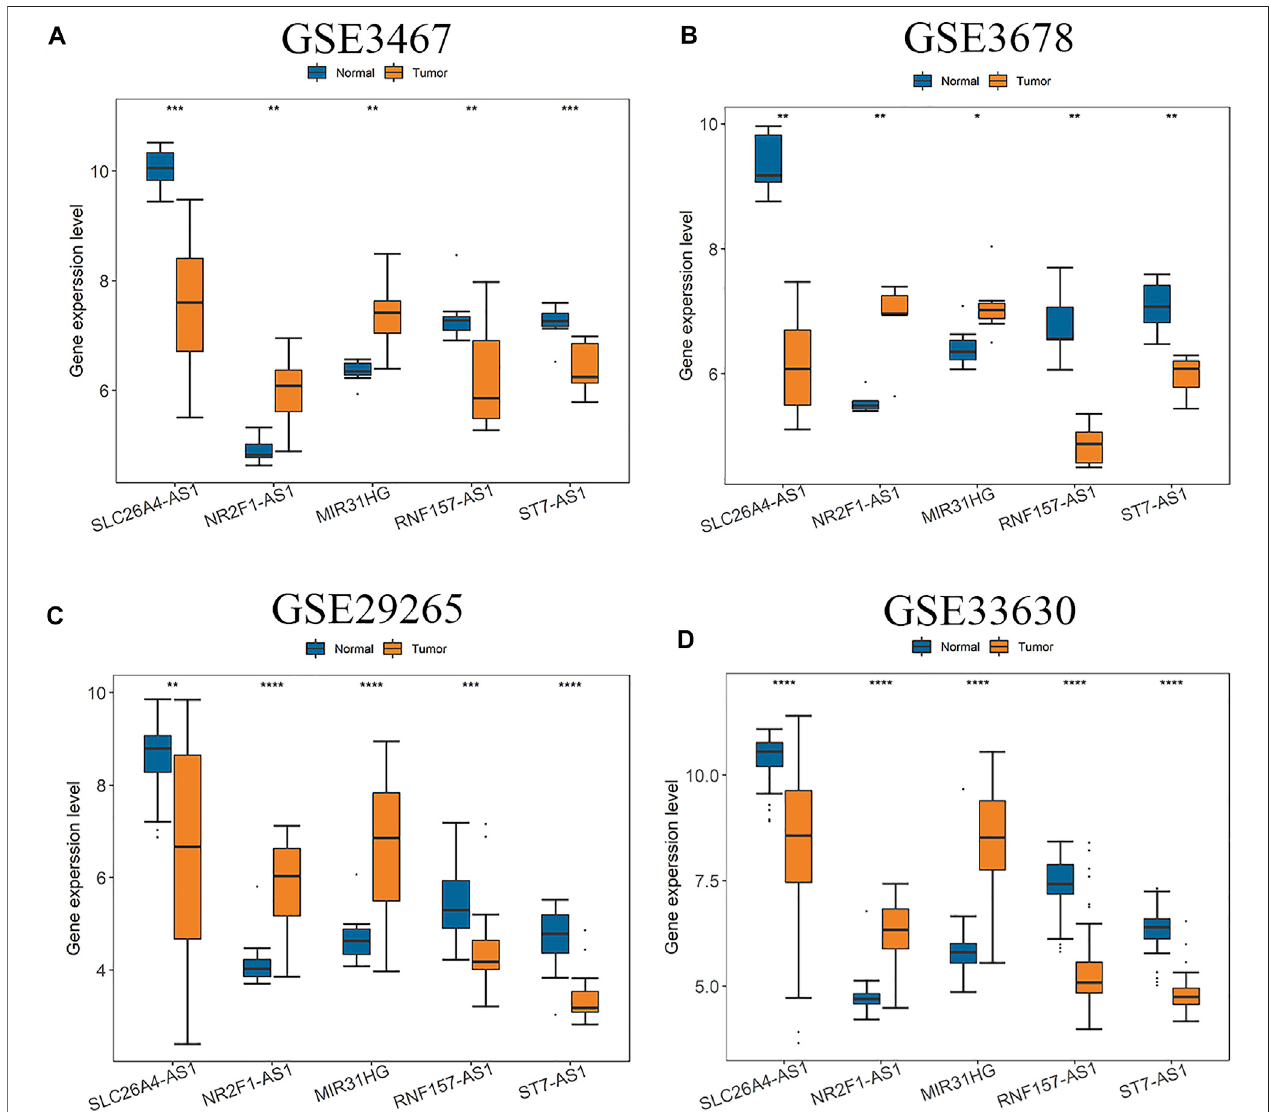
FIGURE 2 | Expressions of fi ve hub lncRNAs in PTC compared with normal tissues in (A) GSE3467, (B) GSE3678, (C) GSE29265 and (D) GSE33630 dataset. (*: p < 0.05, **: p < 0.01, ***: p < 0.001).